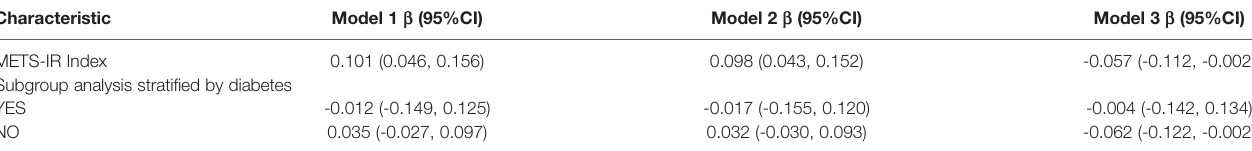
TABLE 5 | Analysis between METS-IR index with onset age of asthma.